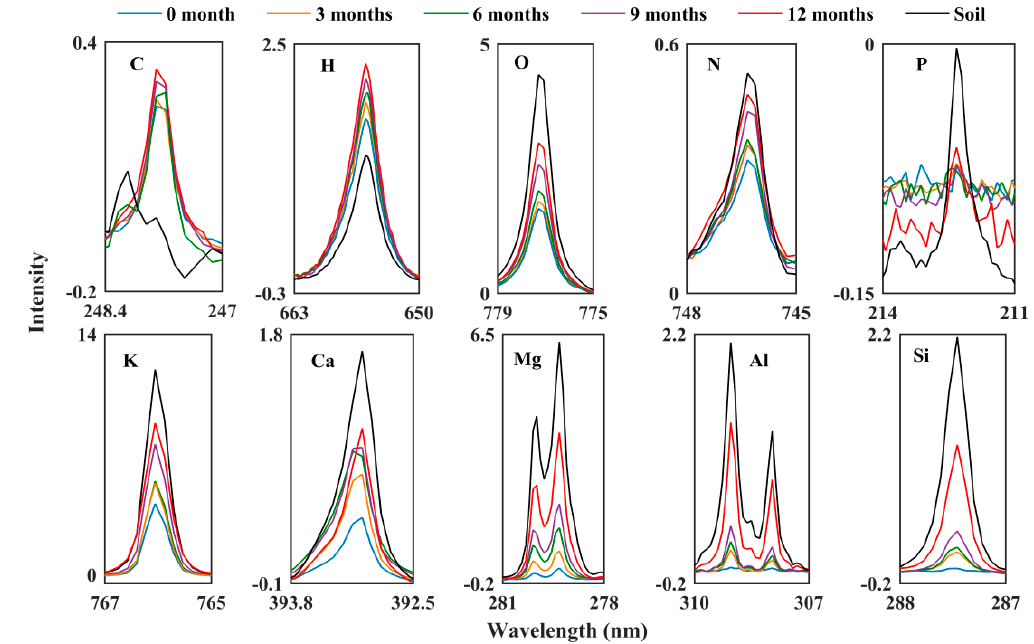
Figure 4. Average LIBS spectra of PA films and soil.